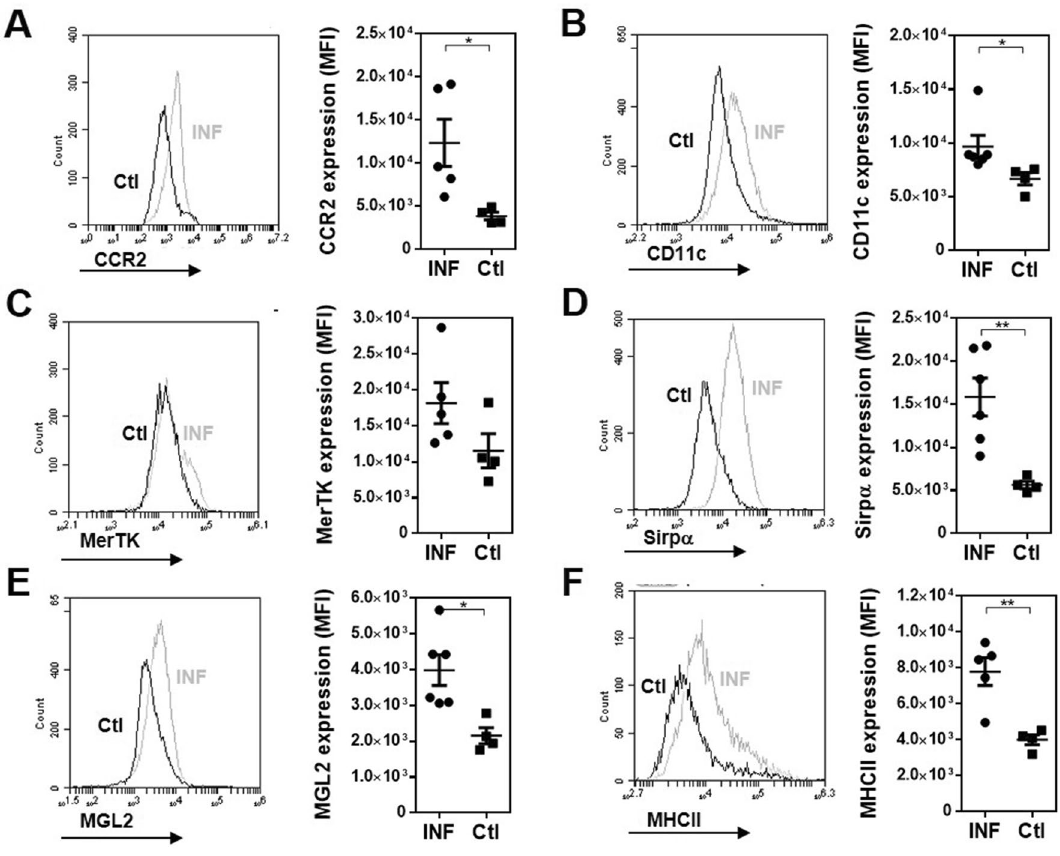
Figure 2. Peritoneal F4/80 + cell phenotype in F. hepatica MGL2-DTR mice. Expression of CCR2 ( A ), CD11c ( B ), MerTK ( C ), Sirpα ( D ), MGL2 ( E ) and MHC class II ( F ) is shown in F4/80 + peritoneal cells from F. hepatica infected mice (INF) and non-infected animals (Ctl). Grey lines in histograms represent infected mice while black lines indicated control mice. A representative figure of three independent experiments is shown (± SEM, indicated by error bars). Asterisks indicate statistically significant differences (* p < 0.05, ** p <